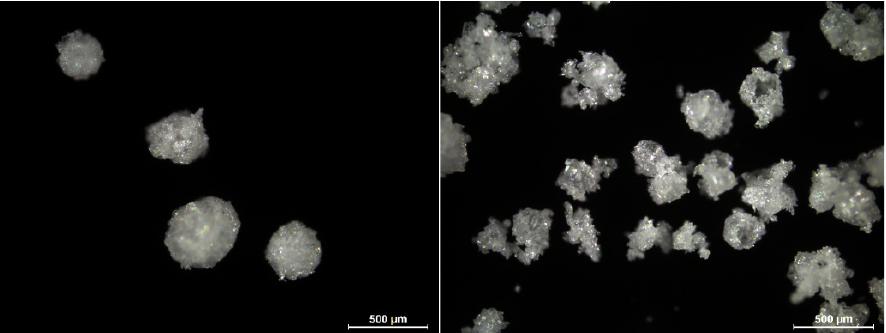
Table 1. Influence of batch size during MSMPR crystallization on the flowability of the QESD MF agglomerates (mean ± s, n = 3).